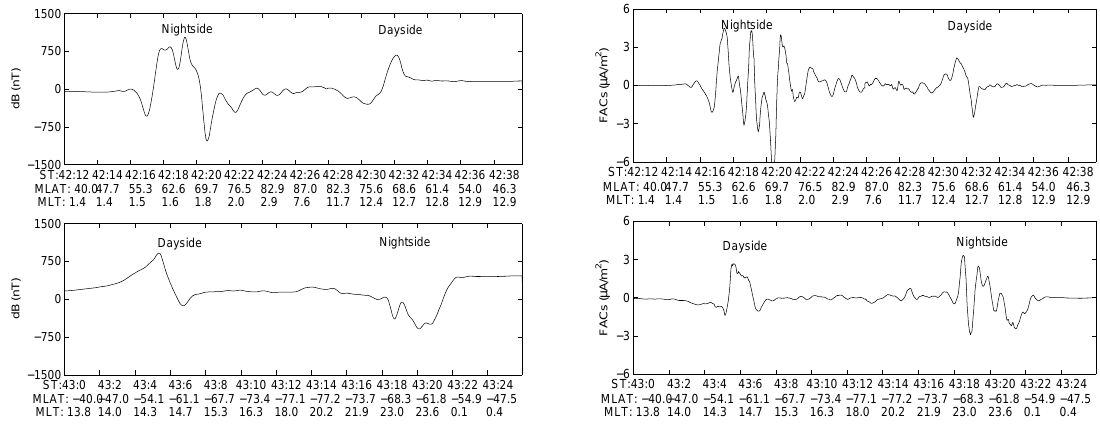
Fig. 2. Examples of the storm-time magnetic measurements and derived FACs for individual CHAMP passes over the north and south poles.